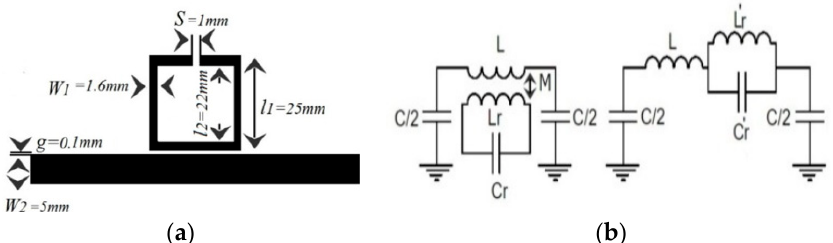
Figure 2. ( a ) Layout of the e-textile transmission line loaded with one SRR. ( b ) Lumped element circuit model that considers magnetic coupling between line and SRR.